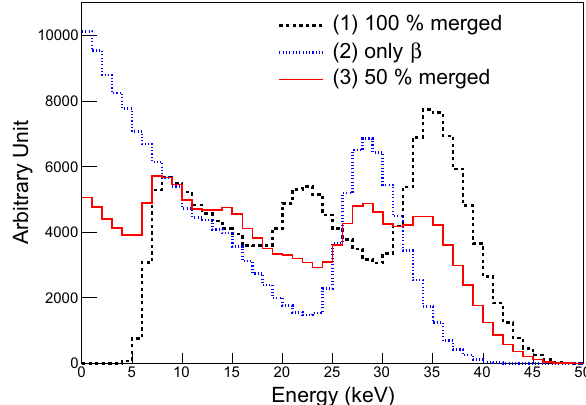
Fig. 9 228 Ra decay spectra from Geant4-based simulation assuming a few different cases of experiments measuring 228 Ac isomeric